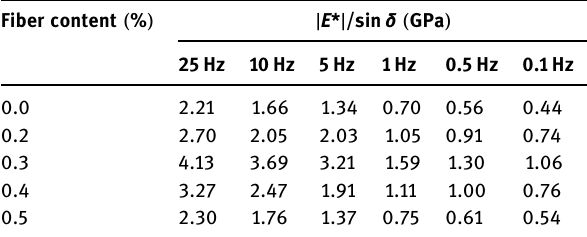
Table 4: Rutting factor, | E * | /sin δ , of AC mixtures at 54.4°C Fiber content ( %